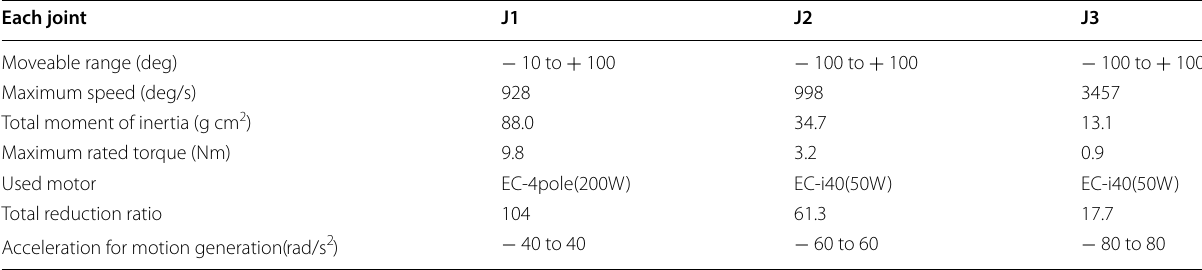
Table 1 Robot arm